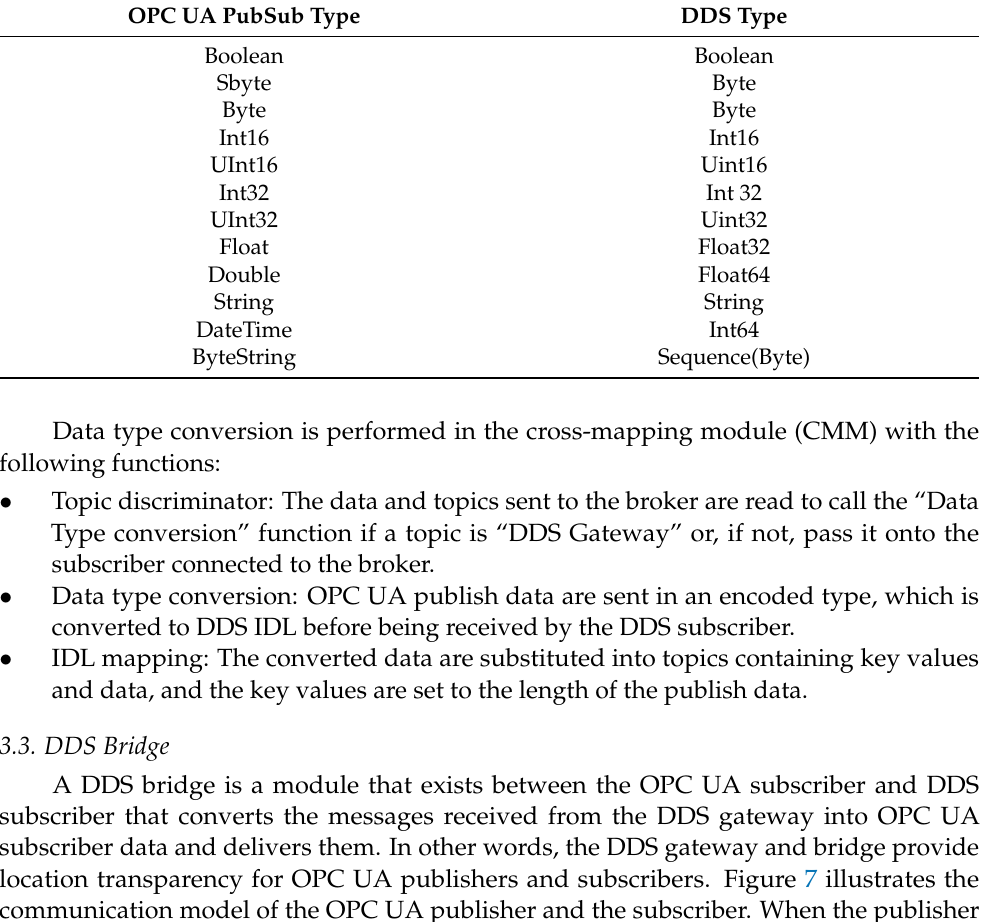
Table 2. Mapping of OPC UA PubSub native types to DDS. OPC UA PubSub